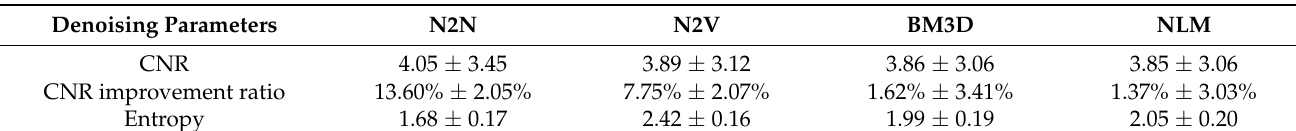
Figure 4. Distributions of CNRs ( A ) and CNR improvement ratios ( B ) for the results of BM3D, N2N, N2V and NLM. Table 3. Values of CNRs, CNR improvement ratios and entropy presented by N2N, N2V, BM3D and NLM.